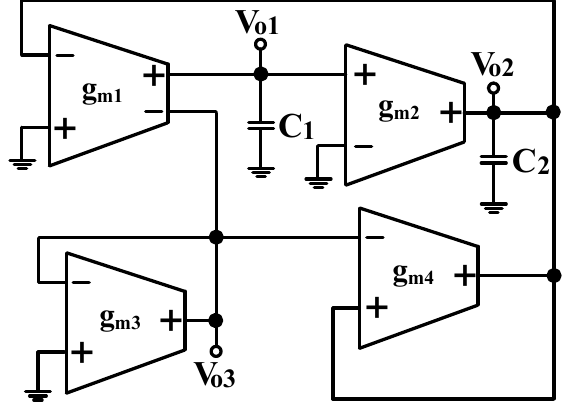
Figure 4. The proposed VM quadrature oscillator.